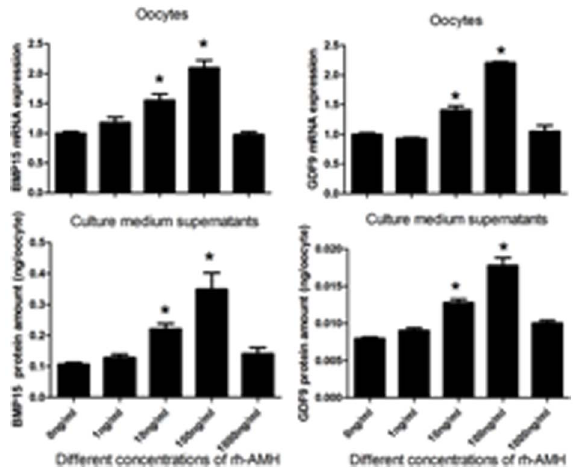
Figure 2. Effect of different concentrations of rh-AMH supple- mented into IVM medium on GDF9 and BMP15 mRNA expression and protein production from the oocytes. GDF9 and BMP15 mRNA in the oocytes were measured by RT-PCR, and GDF9 and BMP15 proteins in IVM-medium were measured by ELISA, respectively. Oocytes were harvested at 16–18 h after IVM. *Indicates significant differences (p , 0.05) compared to the control group. Data were from 3 replicates.